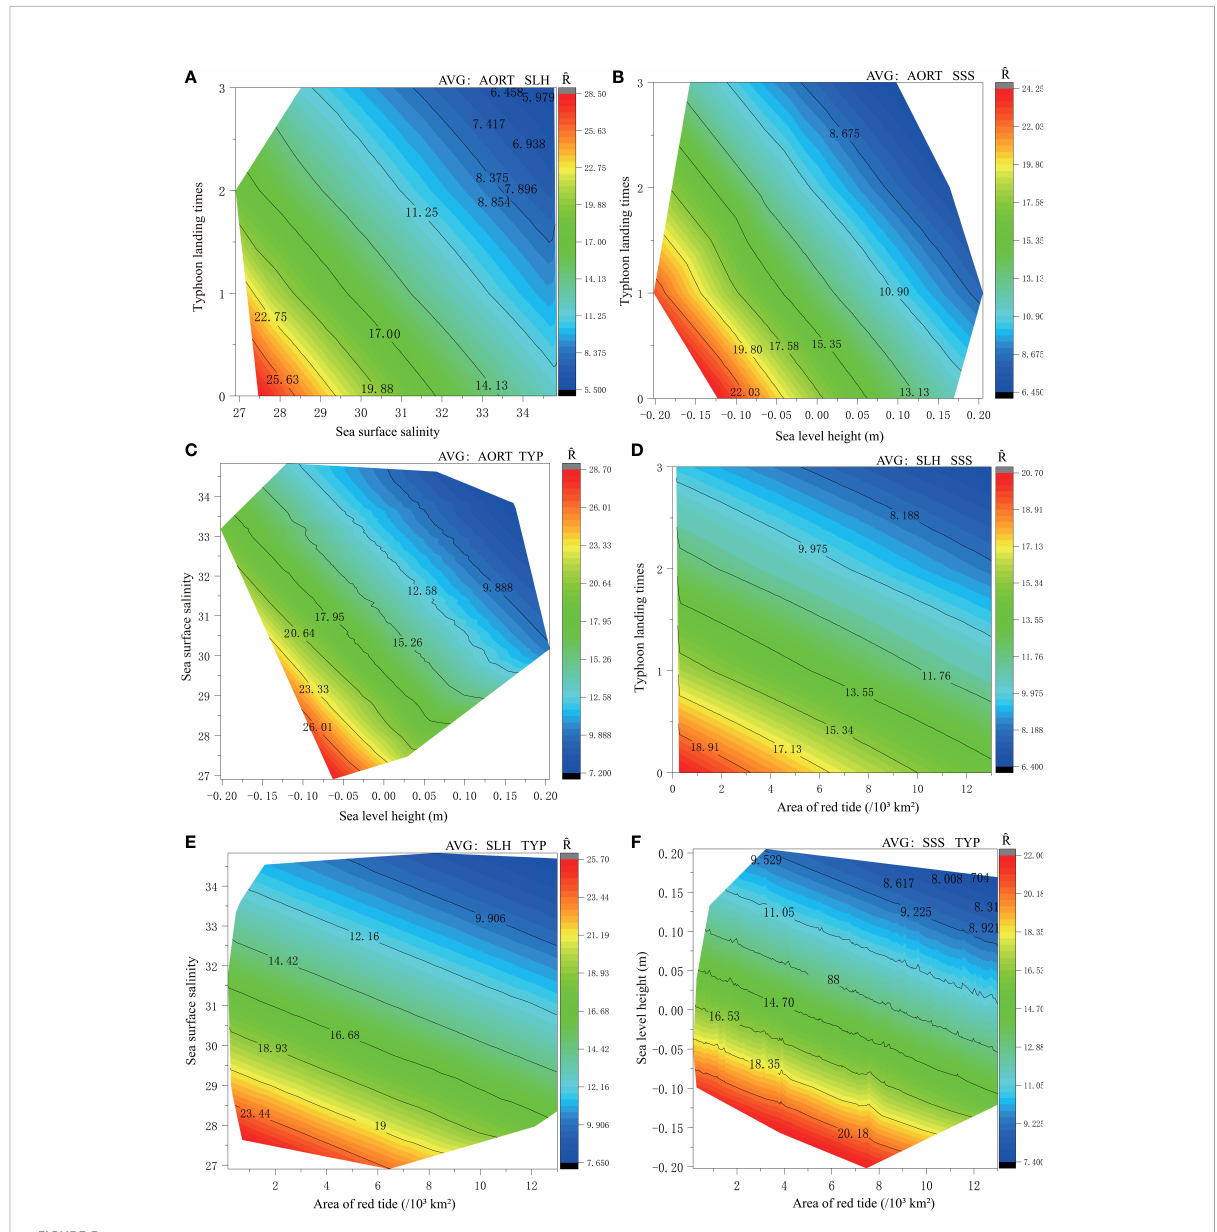
FIGURE 5 Contour map of recruitment with different environmental factors combinations. Note: Ata given spawningbiomass level(averagevalue of 6.008 × 103t), choose to controltwo environmental variables (averagevalue: AORT (6.367×103km2), SLH (0.017 m), SSS (31.77) and TYP(1)) to study the effect of a combinationof two other different environments onrecruitment.The control variables wereselected as follows: When the red tide area (AORT) is the mean, it can be combinedwith the mean ofthe sea level height (SLH) (A) , seasurfacesalinity (SSS) (B) , and typhoon landing times (TYP) (C) respectively to becomethe control variable; When SLH is the mean, it can be combined withthe mean ofSSS (D) and TYP (E) , respectively, to become the control variable; Finally, SSS and TYPwereaveraged as control variables (F) . Ȓ epresents the predicted value of